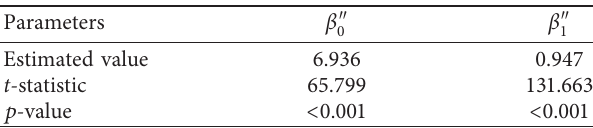
Figure 3: The effect of crowding level and alighting passenger volume on alighting time. (a) Relation between alighting passenger number and alighting time under given crowding level. (b) Relation between crowding level and alighting time under given alighting passengers. Table 5: Parameter estimations of bus dwell time model based on OLS.